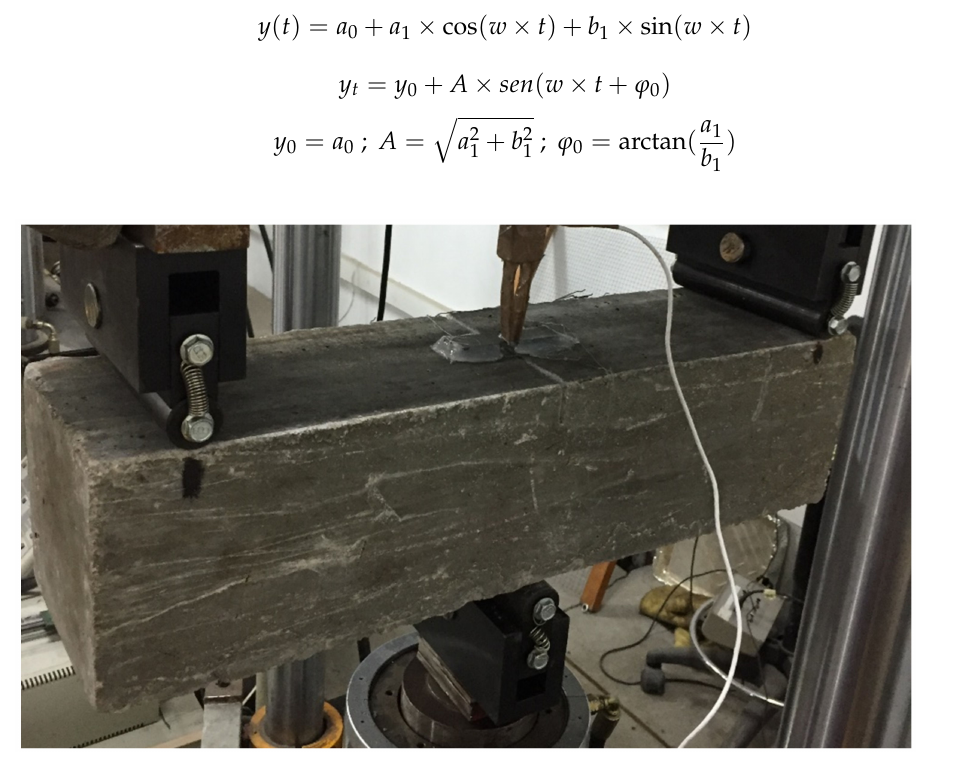
Figure 5. Fatigue